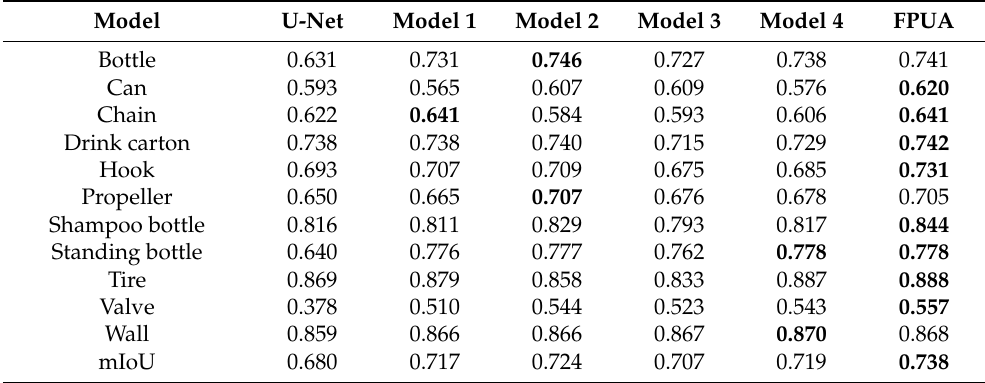
Table 5. Segmentation results for ablation experiment. The best segmentation accuracy for each class is marked